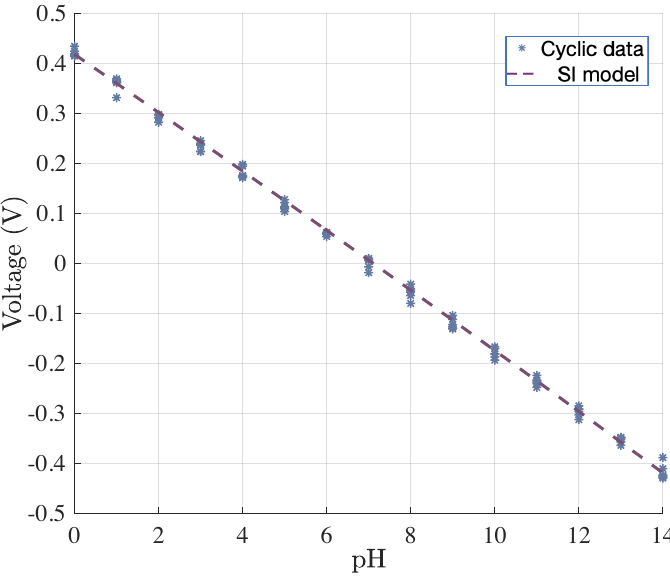
Figure 11. SI model